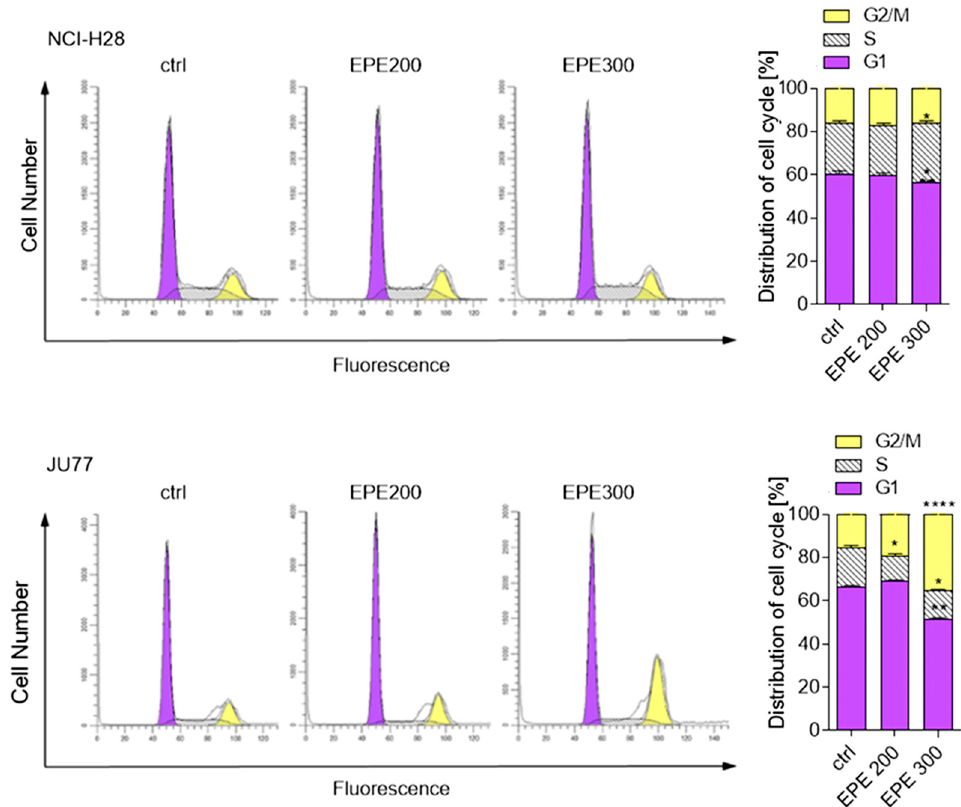
Figure 3. Effect of EPE on cell cycle distribution in malignant pleural mesothelioma (MPM) cells. Cells were treated with increasing concentration of EPE (200 µg/mL EPE200; 300 µg/mL EP300) for 24 h. Then, samples were submitted to flow cytometry analysis after propidium iodide (PI) staining. Histograms are representative of three independent experiments, and the graphs display the percentage of cells in the G1, S, and G2 / M phases. Data are means of three independent experiments ± SD, * p < 0.05, ** p < 0.01, **** p < 0.001 compared to